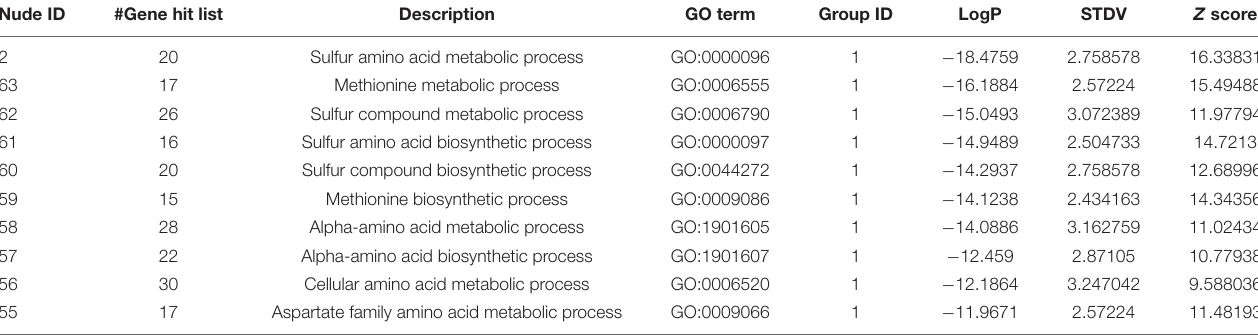
TABLE 2 | The information of the nudes clustered in Figure 3H .